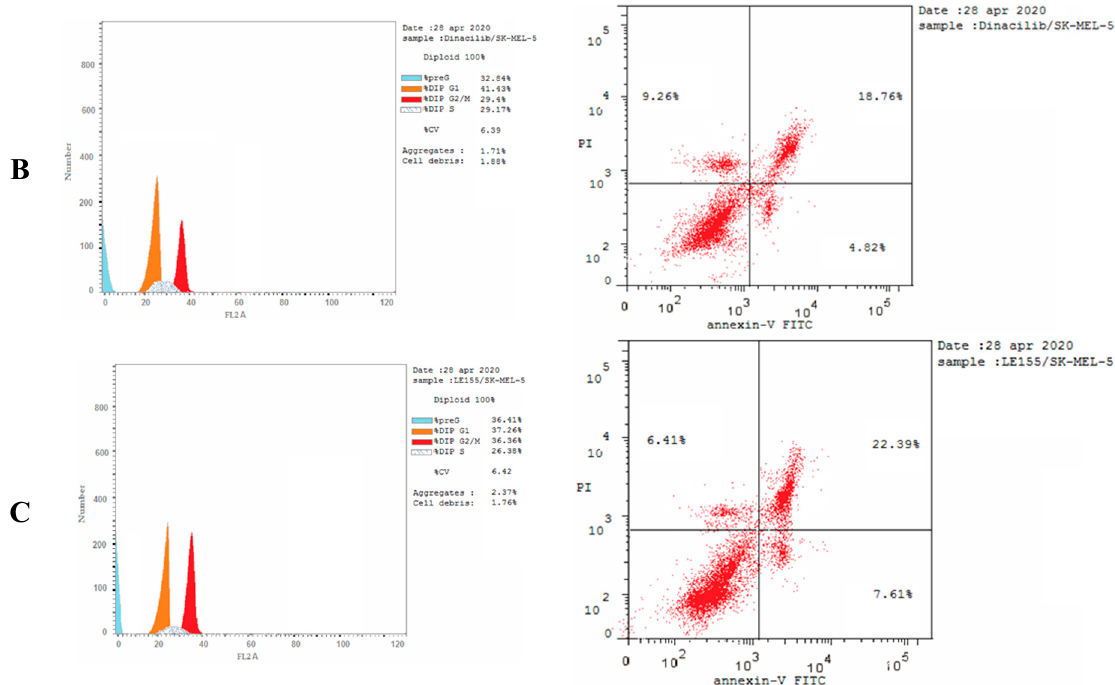
Figure 8. Cell cycle analysis and apoptosis induction analysis against SK-MEL-5 using annexin V/PI at IC 50 . Concentrations representing the growth arrest at the pre-G1 (G0) and G2/M phases. ( A ) Untreated cells, ( B ) treated cells with Dinaciclib, and ( C ) treated cells with 3c . The test was repeated three times, and 3c and the reference were incubated for 24 h (2 × 10 5 cells/well) at 37 °C.